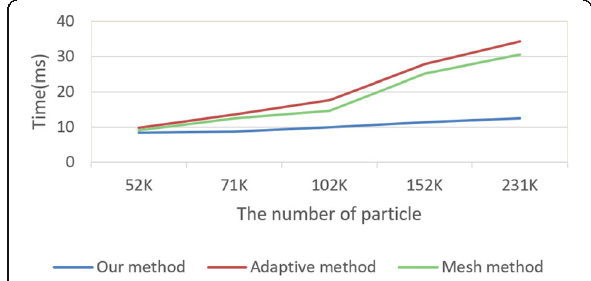
Fig. 13 Comparison of the three rendering